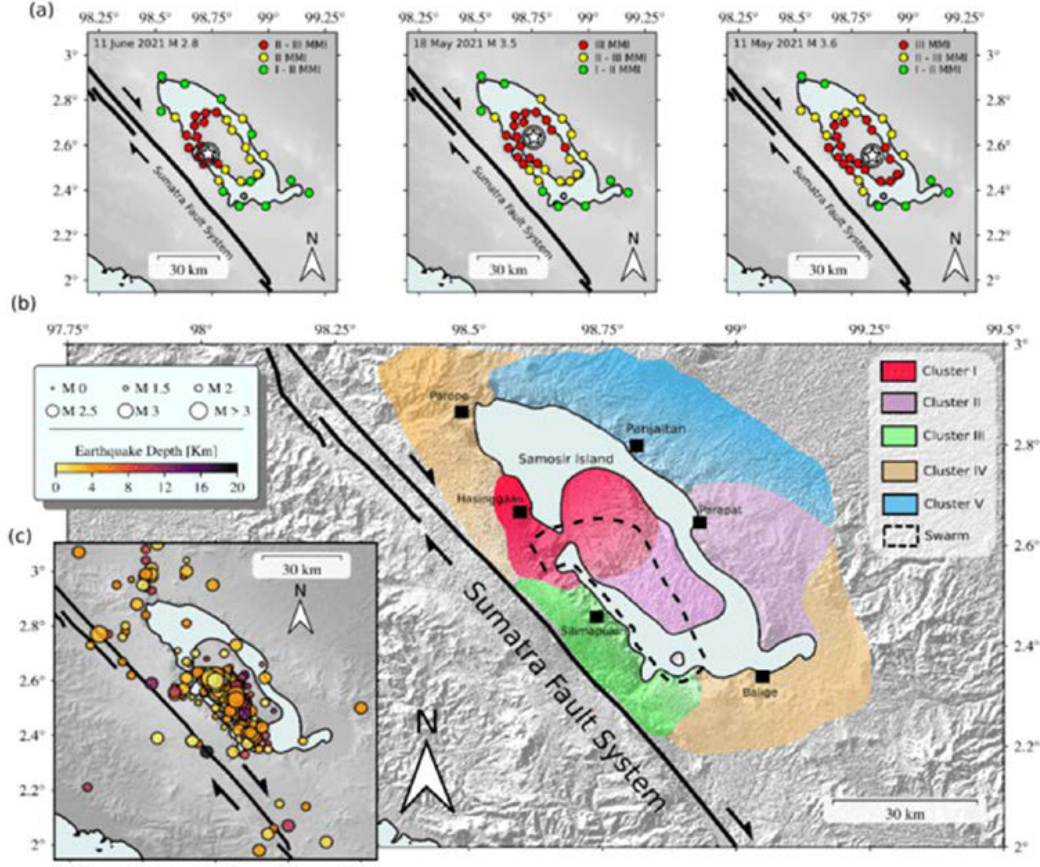
Fig. 7: (a) Clusters of zonation derived from the combination of dominant frequency and amplification (A) in the Toba area. (b) The area is divided into five clusters: Cluster I in northern Samosir Island and Hasinggaan, Cluster II in southern Samosir Island and Parapat, Cluster III in Silimapuluh, Cluster IV in Balige and Paropo, and Cluster V in Panjaitan. (c) Swarm earthquake location in the Toba area.